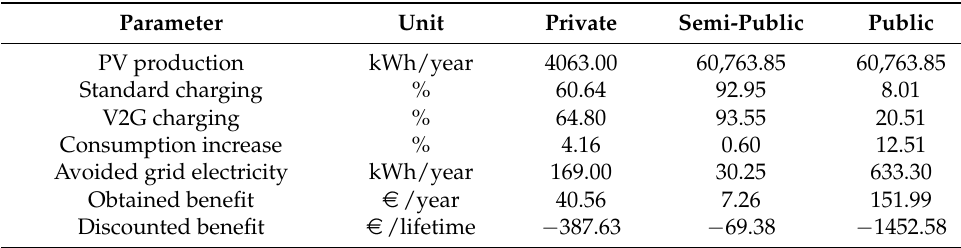
Table 10. Self-consumption of PV-generated electricity of different charging cases (source: own